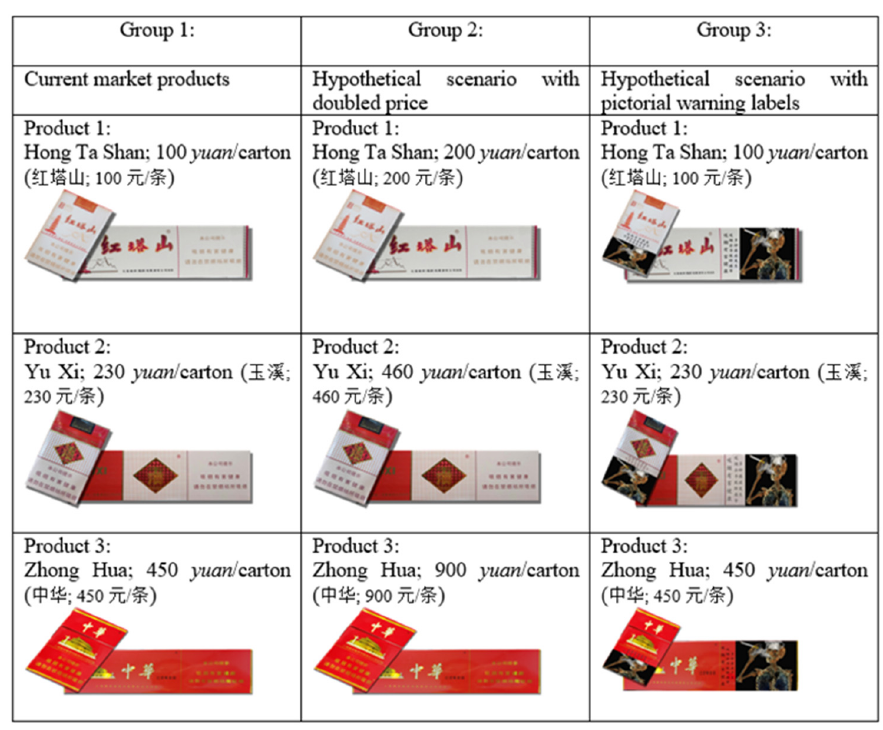
Figure 4. Warning Packages Applied in Survey Experiment, Including Texts and Pictures.